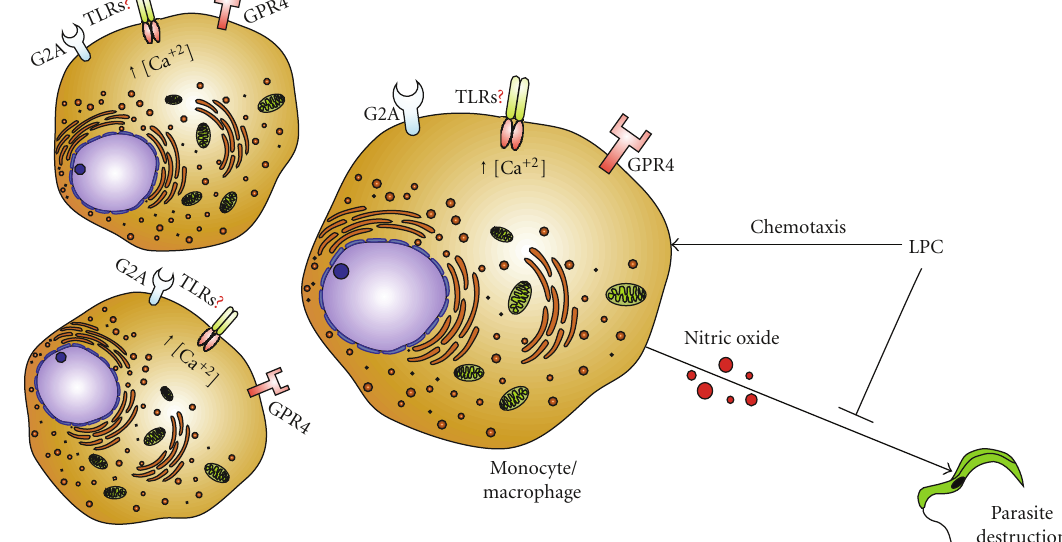
Figure 1: LPC-induced signaling on monocytes and macrophages. LPC is a signaling molecule that may act through di ff erent receptors on cell surface such as G2A and GPC4. Despite its description as a proinflammatory molecule, LPC-mediated signaling through TLRs is not demonstrated yet. LPC induces cell chemotaxis which ultimately increases the number of cells in the wound site. Also, LPC-treated cells undergo a decrease on NO synthesis when stimulated by parasite or LPS. Finally, a transient increase on intracellular calcium is also reported in such cells. These combined e ff ects enhance the number of cells prone to T. cruzi invasion.